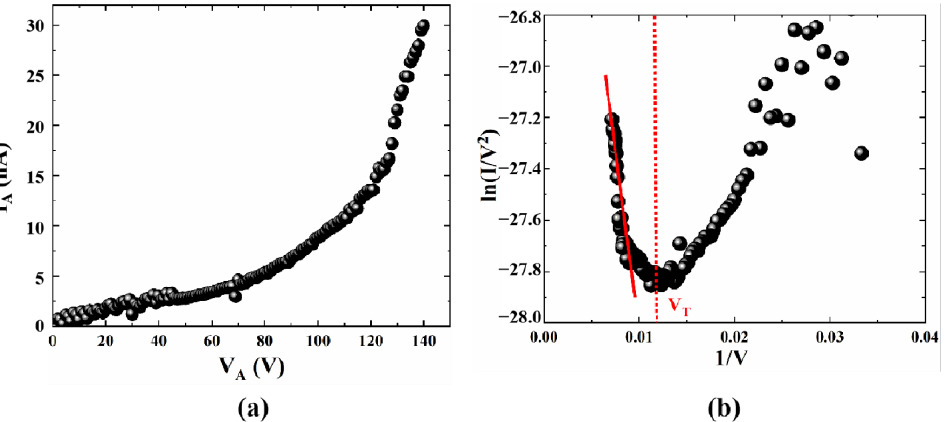
Figure 6. The electrical performance test curves, ( a ) emission current versus collector voltage and ( b ) F-N fitting curve.